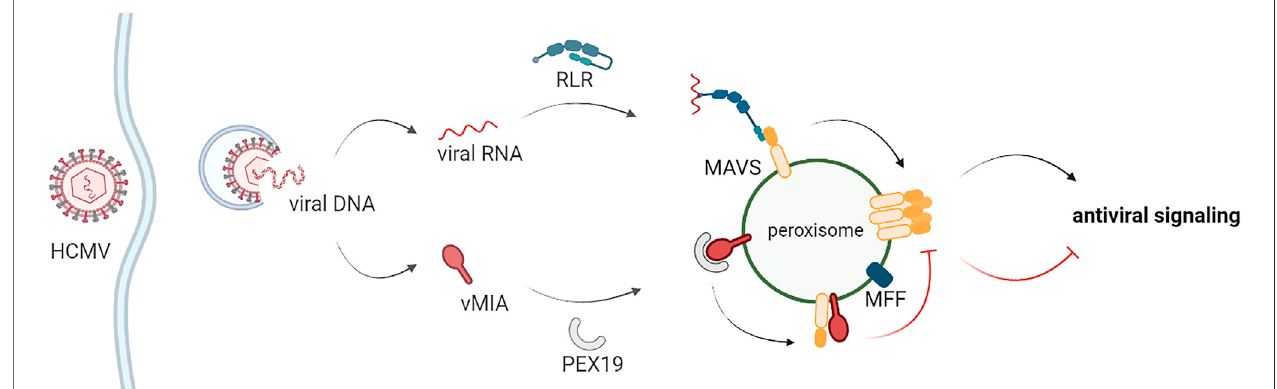
FIGURE 6 | Schematic representation of the proposed model for the vMIA-dependent inhibition of the peroxisomal antiviral signalling. Upon stimulation, RIG-I-like proteins interact with MAVS at peroxisomes, inducing its oligomerization and the downstream production of direct antiviral effectors. HCMV vMIA is able to speci fi cally evade this peroxisomal antiviral signalling. vMIA interacts with PEX19 at the cytoplasm and travels to peroxisomes, where it interacts with MAVS. This interaction interferes, in an MFF-dependent manner, with the formation of MAVS oligomers and inhibits the consequent activation of the downstream antiviral signalling.